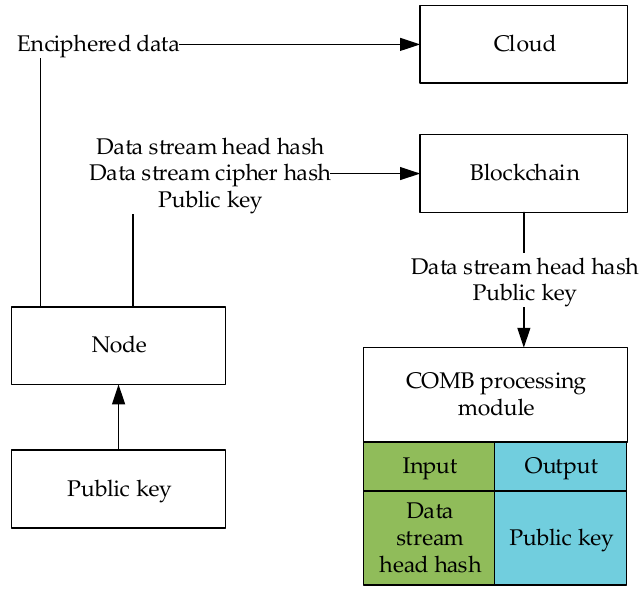
Figure 4. IoT node data processing flow.